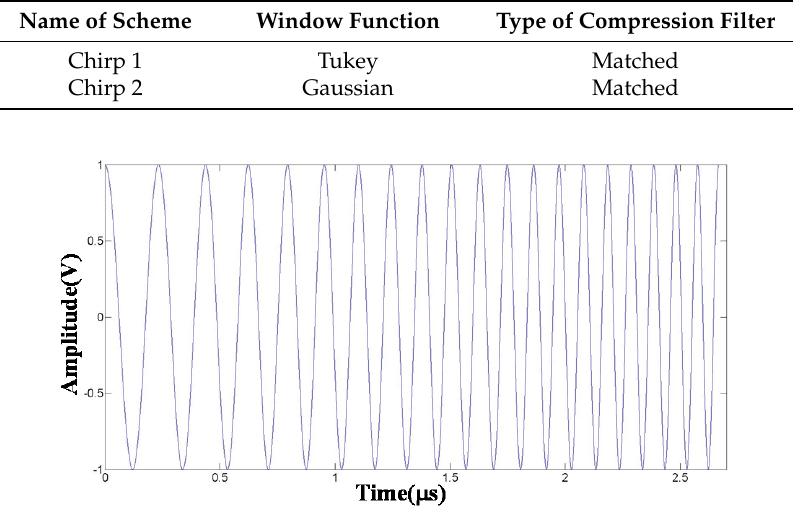
Figure 4. Chirp without window (w( t ) = 1).